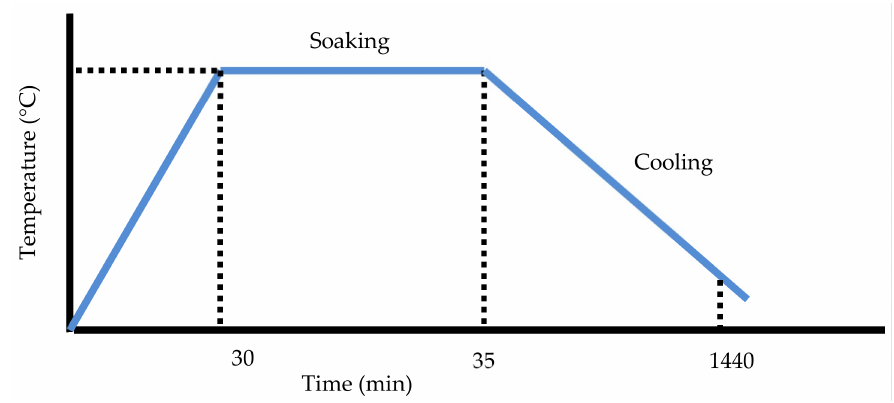
Figure 1. Schematic of annealing temperature increment process.